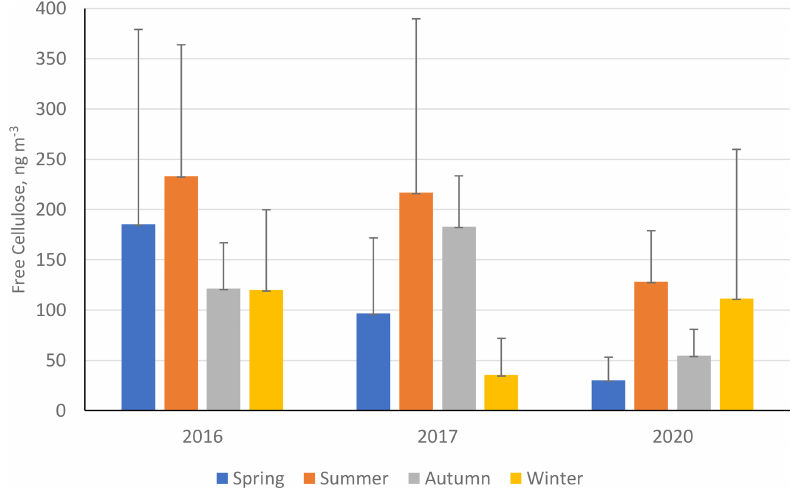
Figure 8. Seasonal mean averages of cellulose concentrations (ngm − 3 ) at ANDRA-OPE (rural site) during the three separate sampling periods: 2016, 2017, and 2020. Black error bars represent 1 standard deviation of the seasonal means. Only positive error bars are shown to aid clarity. Seasons are defined as December–February (winter), March–May (spring), June–August (summer), and September–November (autumn).